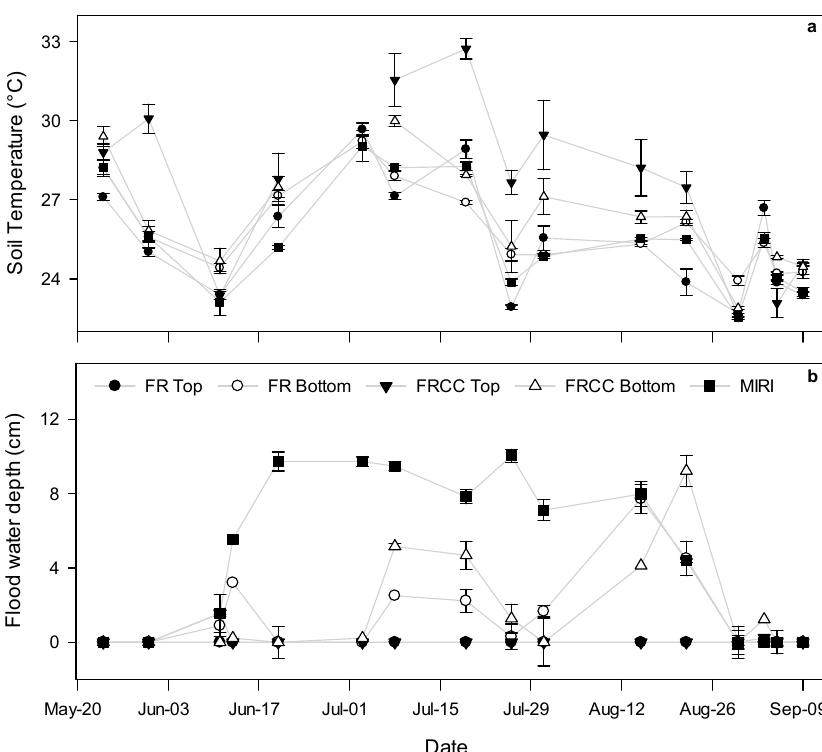
Figure 3. ( a ) Soil temperature (0–5 cm) and ( b ) floodwater depths at the top and bottom sections of a furrow-irrigated rice field (FR), a furrow-irrigated rice with winter cover crop field (FRCC) and a multiple-inlet rice irrigation field (MIRI). Data shown are average ± standard error ( n = 5).